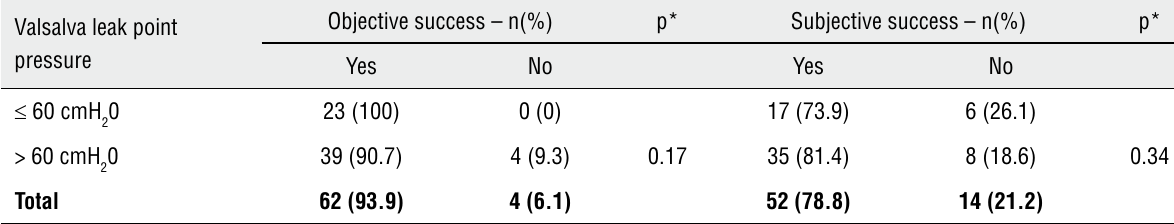
Table 2 - Role of Valsalva leak point pressure on postoperative success rates. Valsalva leak point pressure